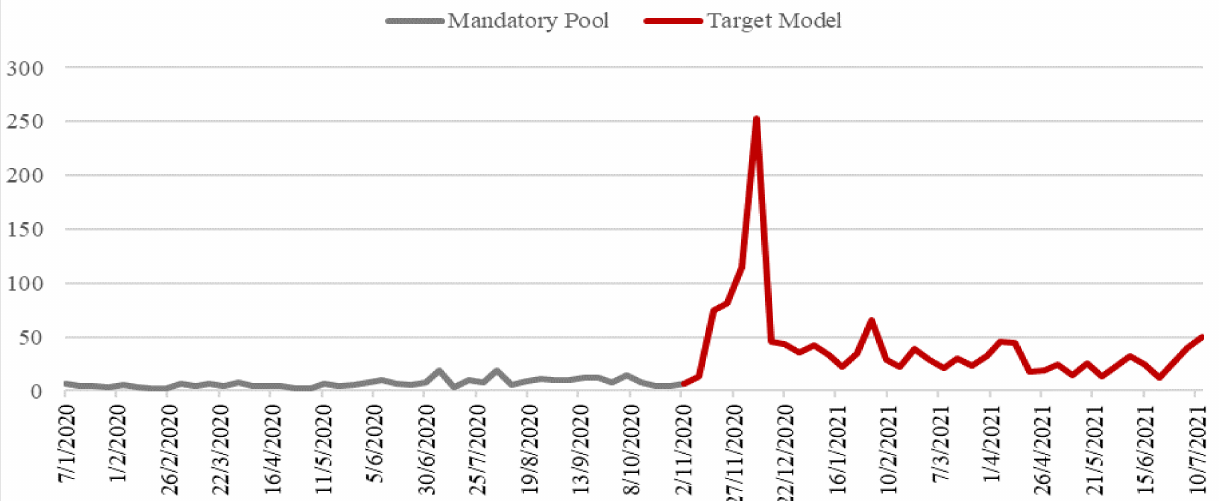
Figure 16. Weekly Standard Deviation of imbalance prices in Greece, (January 2020–July 2021), Source: Hellenic Transmission System Operator and Authors’